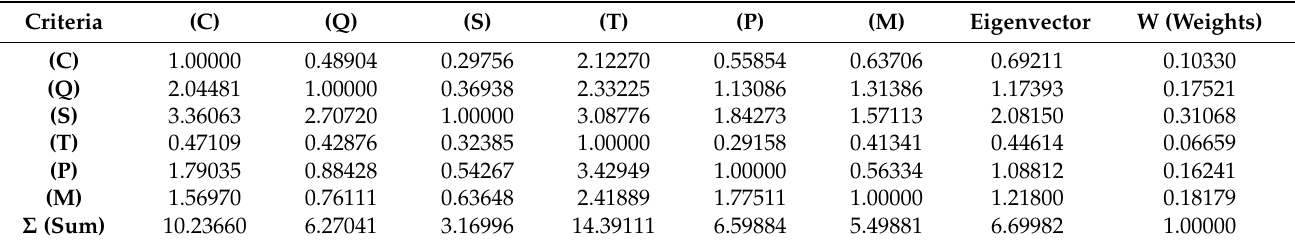
Table 16. Aggregate matrix AIJ (respondent group).